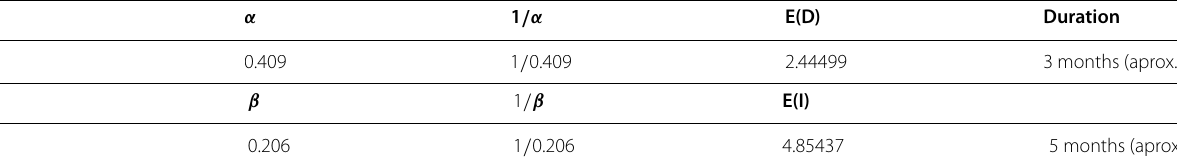
Table 4 Expectation of a decrease and increase in the all-share index. Source: Authors computation with data generated from NSE 1 α